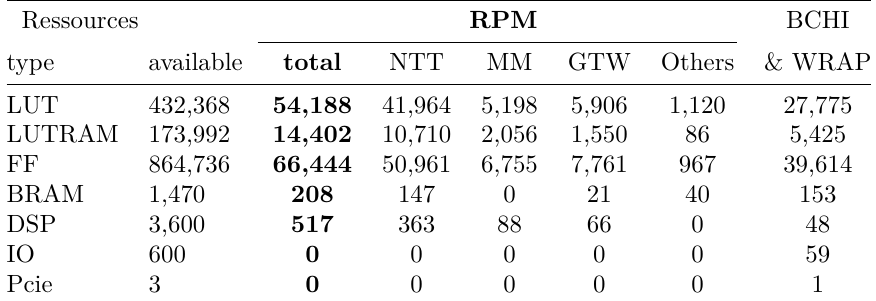
Table 2: Resource utilization post implementation on a Virtex xc7vx690t. Synthesis, placement and route using Xilinx Vivado 2016.3. Frequency